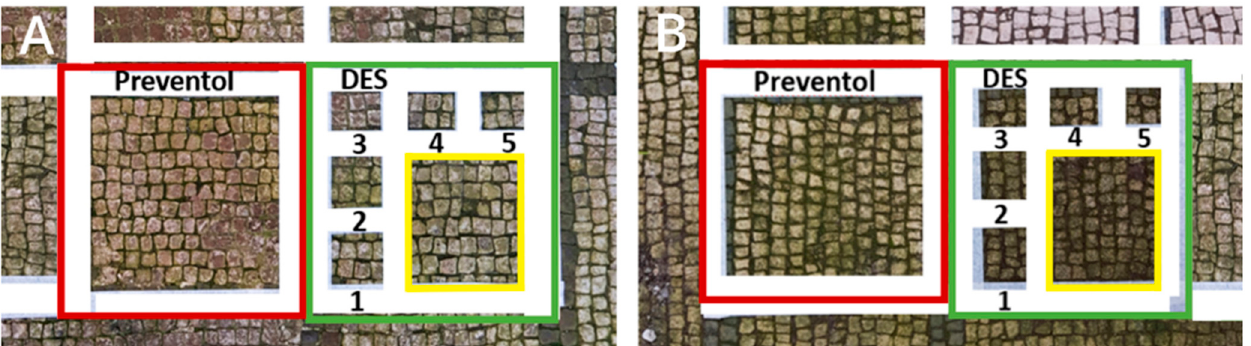
Figure 1. Two selected sample ‐ areas of the mosaic in the Archeological Park of Ostia Antica: Area 1 ( A ) and Area 2 ( B ). The areas provided for the treatment with DESs (code 1–5) have been indicated with the green box, the one with Preventol Rl50 in red, and the untreated area in yellow.